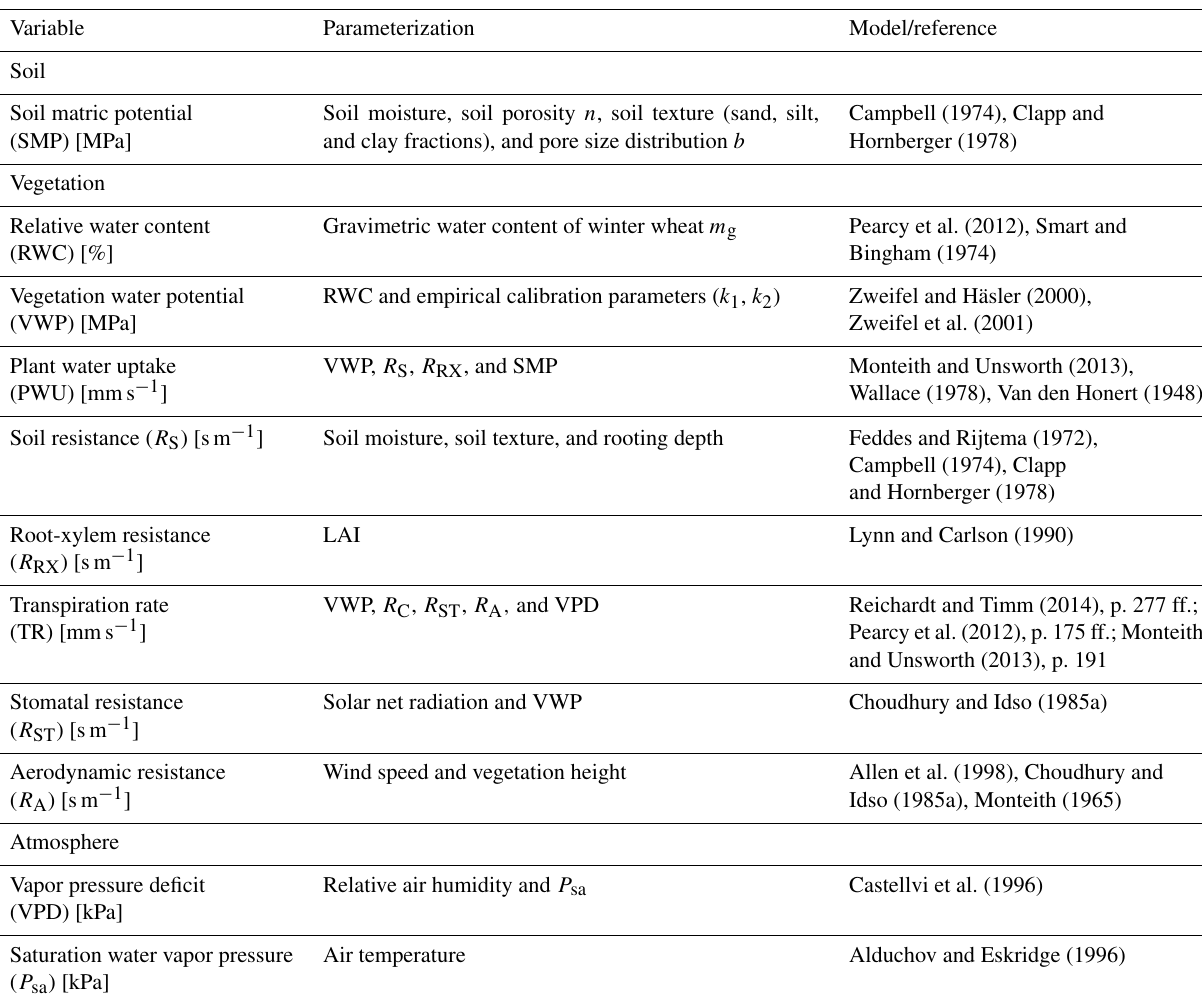
Table 2. Summary of parameterizations and models for the non-directly measured variables in the estimation of plant water dynamics of winter